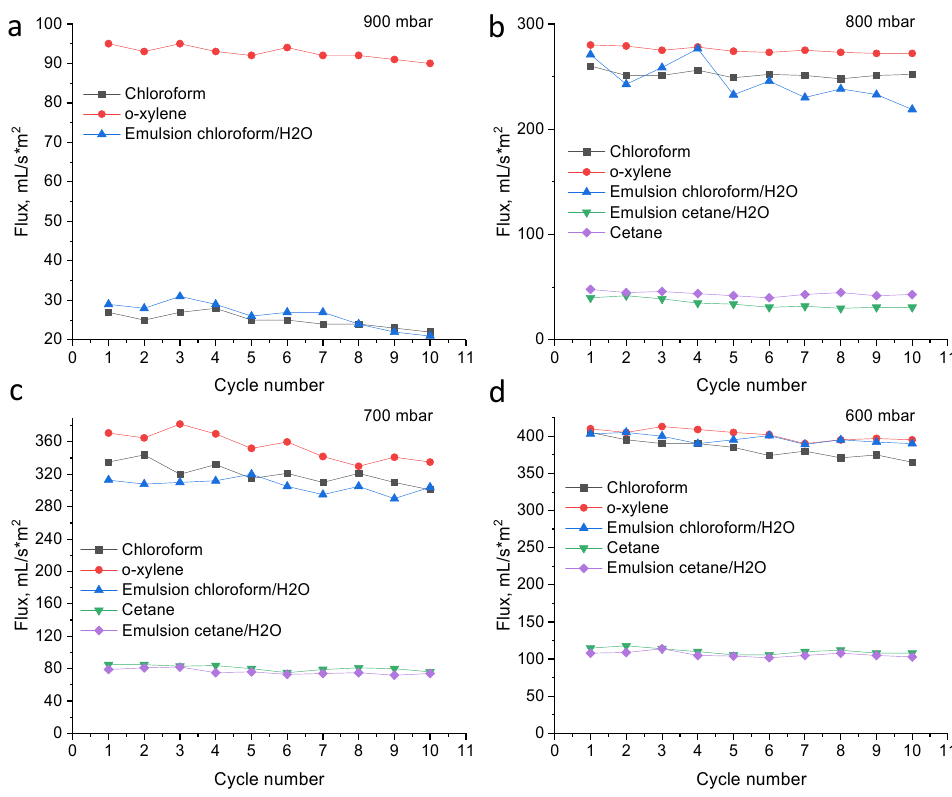
Figure 6. The fluxes of hydrophobic PET TeMs for various solvents and oil/water mixtures after each cycle (pore diameter of 350 nm) at pressure 900 mbar ( a ), 800 mbar ( b ), 700 mbar ( c ) and 600 mbar ( d ).